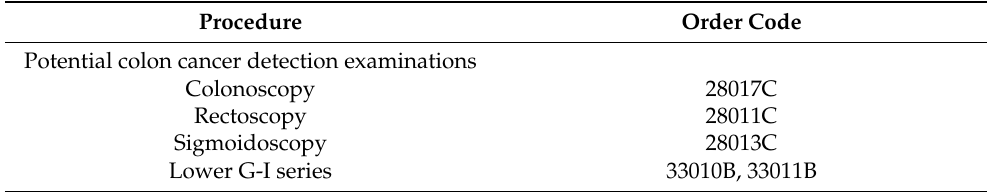
Table A3. Current procedural terminology codes in